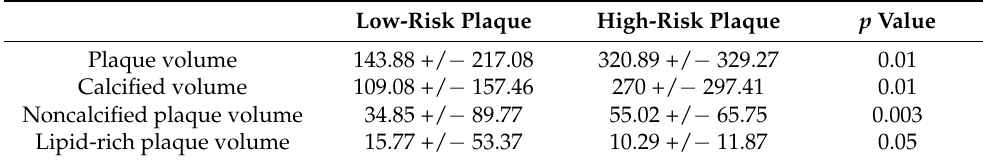
Table 4. Plaque vulnerability markers in low versus high-risk plaques.